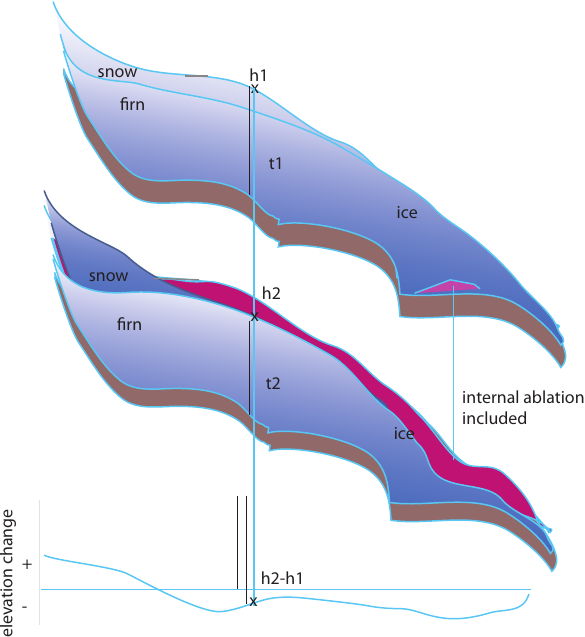
Fig. 1. Calculation of geodetic mass balance between t 1 and t 2 . The mass loss at the surface removes a layer of ice, firn and possibly snow, the gained mass has a much lower density. For this surface layer subject to mass change, a mean density is assumed to convert the volume change to mass change.